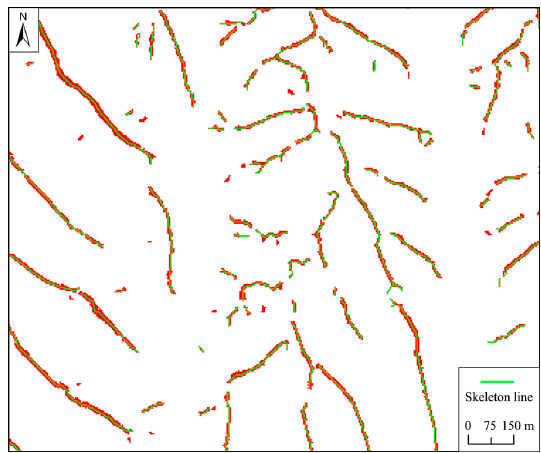
Figure 7. Patch skeleton lines (local area).